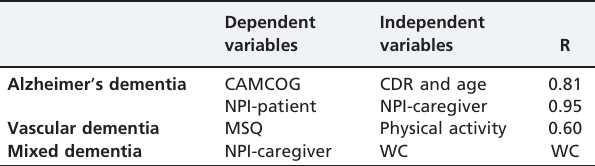
Table 2 - Stepwise linear regression analysis according to the correlation of level of physical with dependent and independent variables.